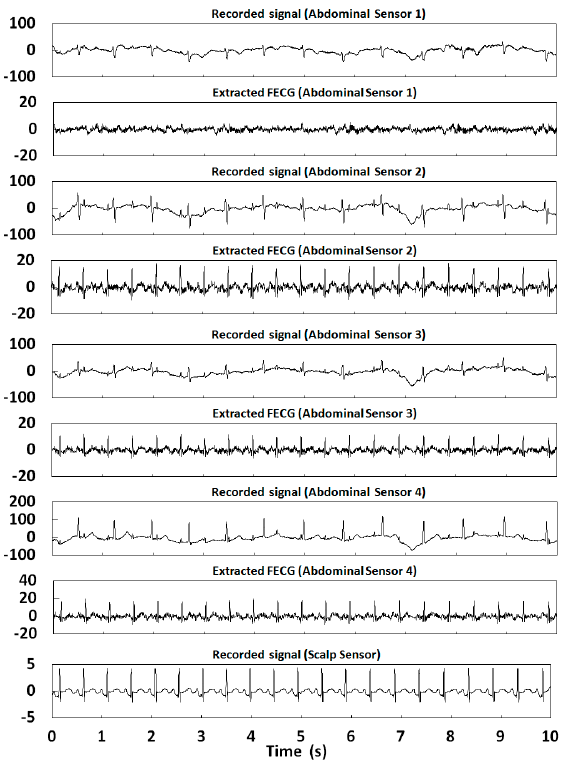
Figure 13. Extraction results for r04 in the ADFECGDB database.